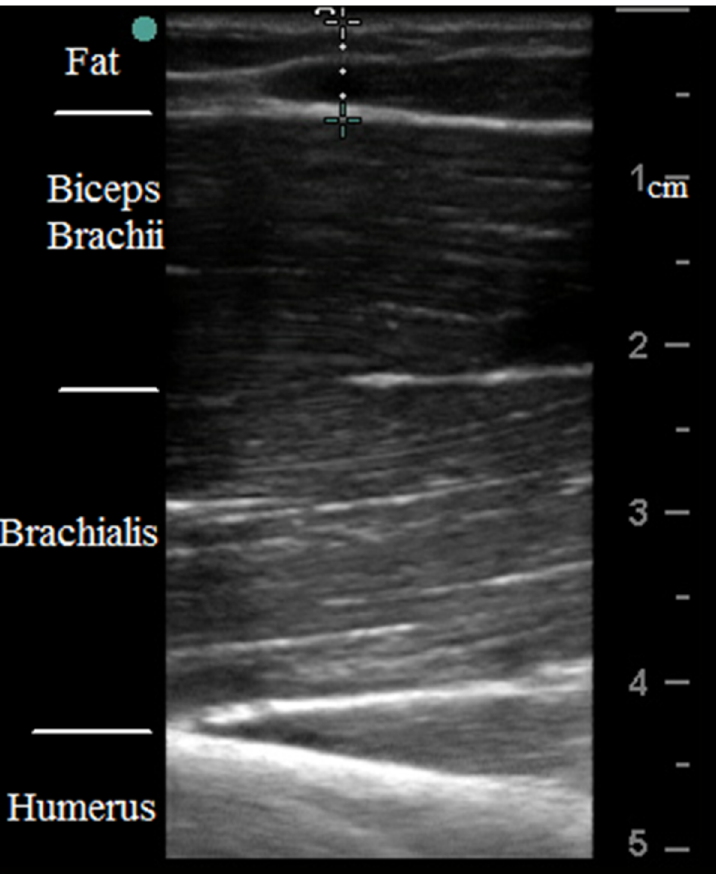
Fig 2. An example of ultrasound data showing the measurement of the SFL